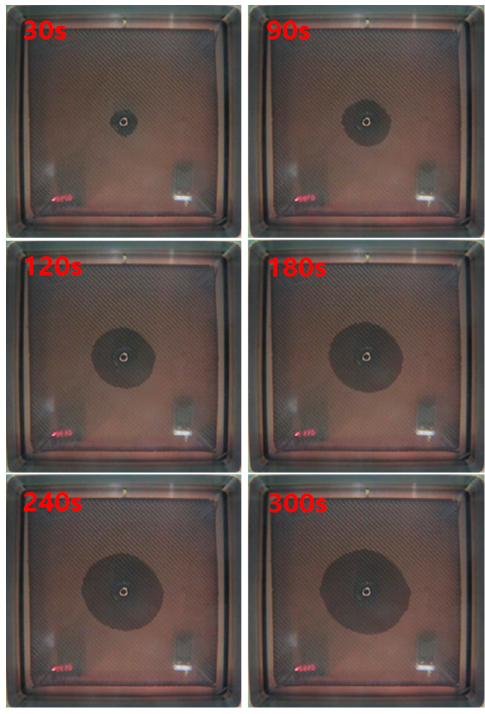
Figure 3. Observation of the resin flow front over time (V. F.: 50%, neat fabric preform).